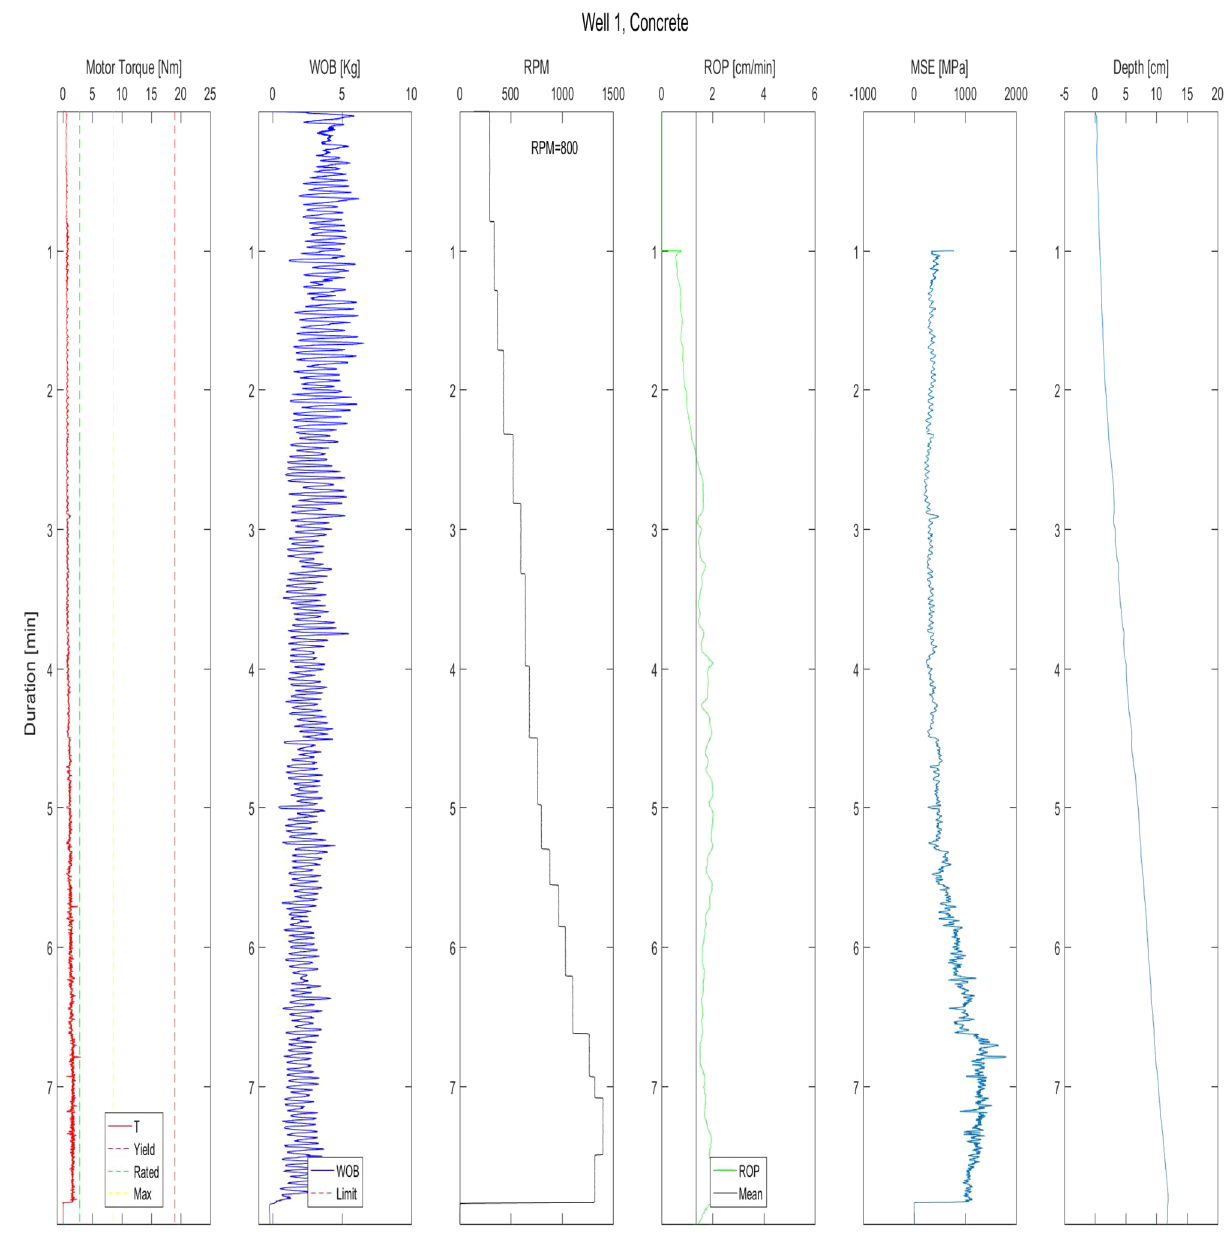
Fig. 10 Well Concrete 1, manual mode with varying